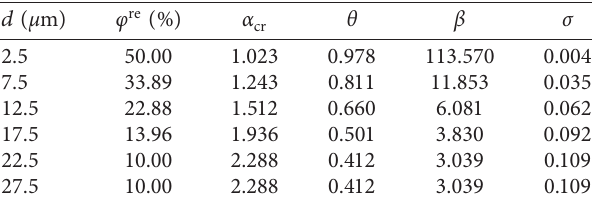
Table 15: Parameter values for con_PLN